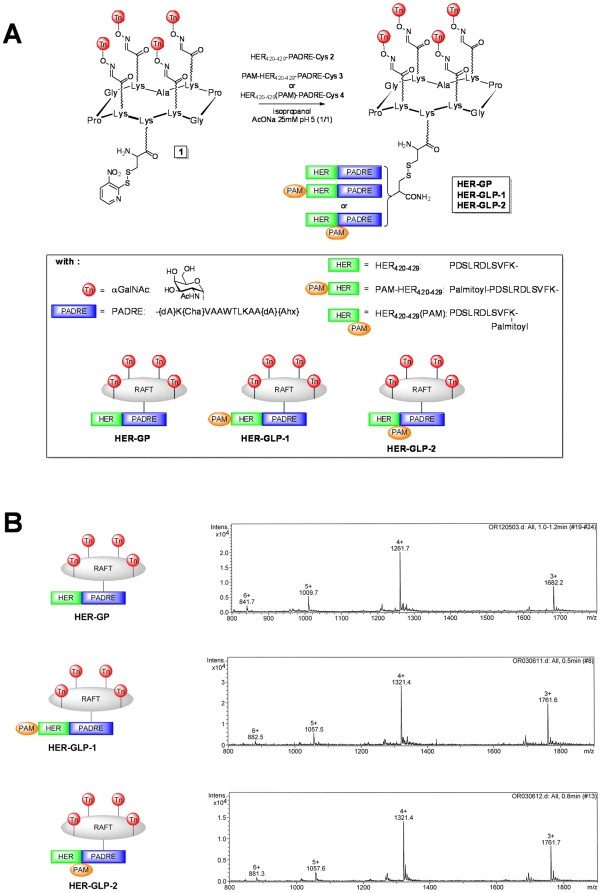
Assembly, structures and mass spectrum analyses of prototype multivalent B, CD4+ and CD8+ epitopes HER-2 glyco-lipopeptide molecules.(A) The RAFT moiety 1 was assembled from an orthogonally protected linear decapeptide following the standard Fmoc/tBu strategy, as we previously described [21]. The amino acid sequences of CD4+ and CD8+ epitopes and cyclic template are given using one letter code. Unusual amino acids are designated as dA (L-alanine), Cha (cyclohexyl alanine) and Ahx (L-2-aminohexanoic acid). Each compound displays clustered Tn analog on the upper domain of the cyclodecapeptide RAFT template. HER-GP and HER-GLP contain respectively either HER420–429-PADRE chimeric peptide or PAM- HER420–429-PADRE chimeric lipopeptide on the lower domain. (B) Mass spectrum (MS) analysis was obtained by electron spray ionization (ESI-MS) in the positive mode. The multi-charged ions observed for HER-GP (m/z: 841.7 [M+6H]6+, 1009.7 [M+5H]5+, 1261.7 [M+4H]4+, 1682.2 [M+3H]3+), HER-GLP-1 (m/z: 882.5 [M+6H]6+, 1057.5 [M+5H]5+, 1321.4 [M+4H]4+, 1761.6 [M+3H]3+) and HER-GLP-2 (m/z: 881.3 [M+6H]6+, 1057.6 [M+5H]5+, 1321.4 [M+4H]4+, 1761.7 [M+3H]3+) correspond to the expected deconvoluated masses calculated for [M+H]+ (5044.3 for HER-GP, 5282.8 for HER-GLP-1 and 5282.9 for HER-GLP-2).